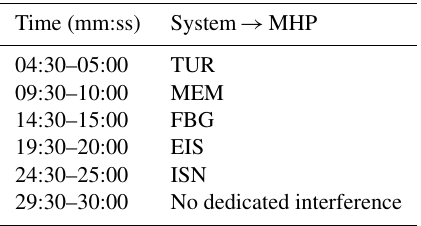
Table 2. The repeating 30min scan sequence during the interference test. Precipitation scan and volume scan together take about 4min 30s to finish and are repeated every 5min.